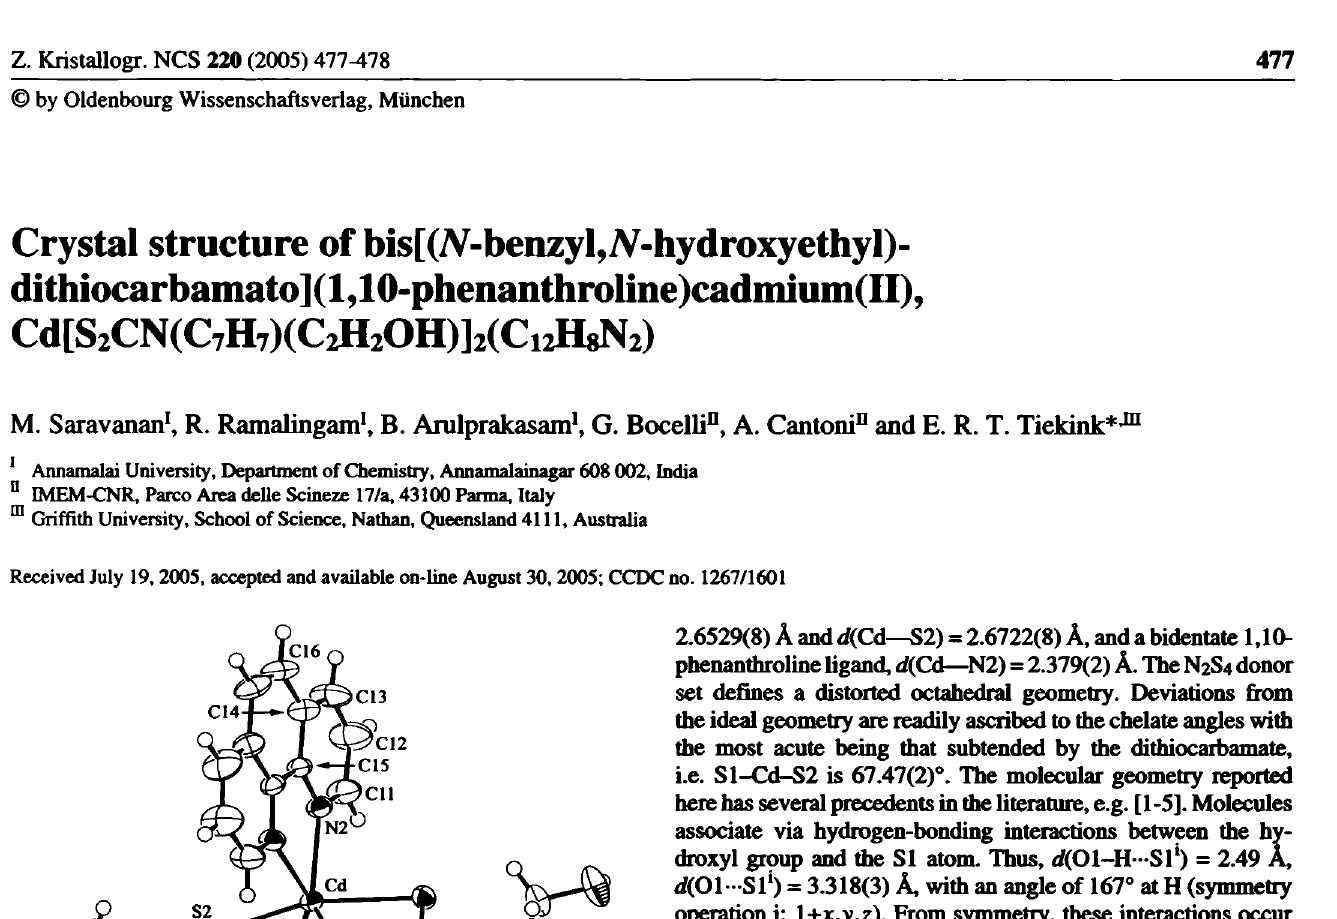
Table 2. Atomic coordinates and displacement parameters (in A 2